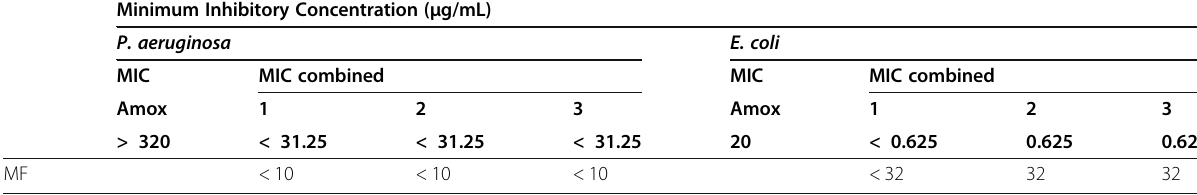
Table 4 Minimum inhibitory concentration (MIC) of Amoxicillin in the absence or presence of compounds at ¼ MIC concentration Minimum Inhibitory Concentration ( μ g/mL)